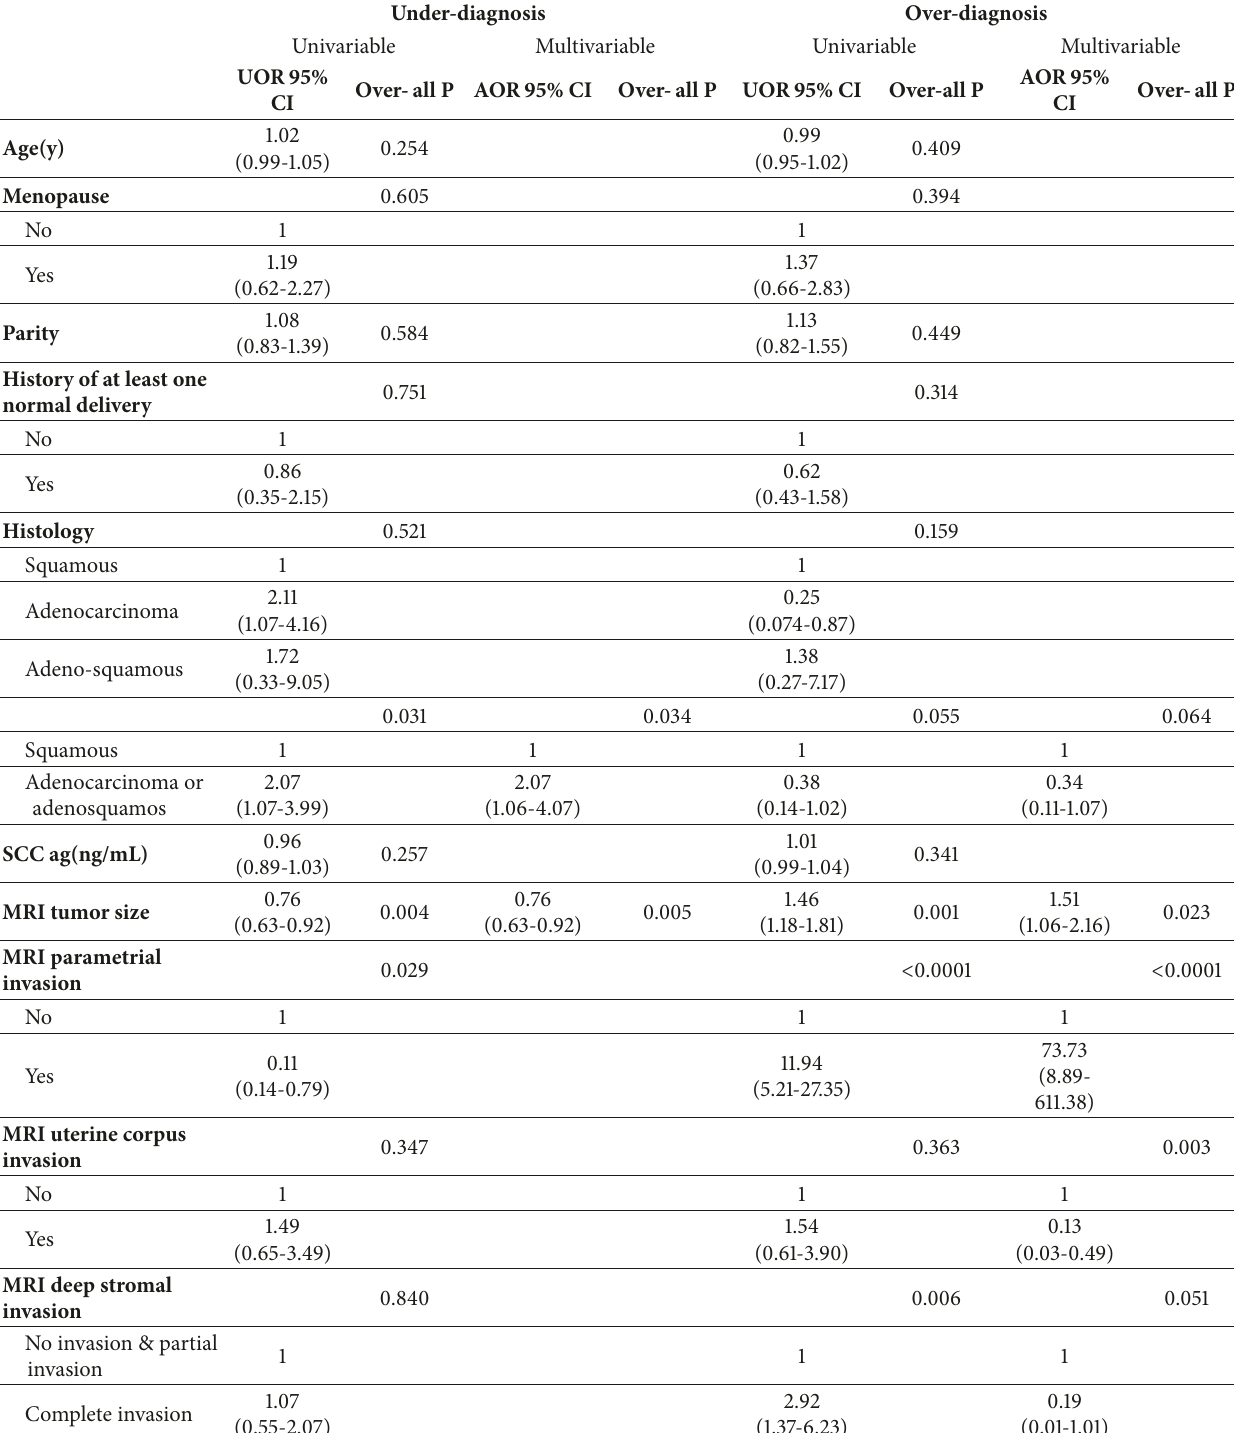
Table 3: Univariable and multivariable analysis of factors associated with diagnostic inaccuracy of preoperative MRI staging. Under-diagnosis Over-diagnosis Univariable Multivariable Univariable Multivariable Over- all P Over-all P Over- all